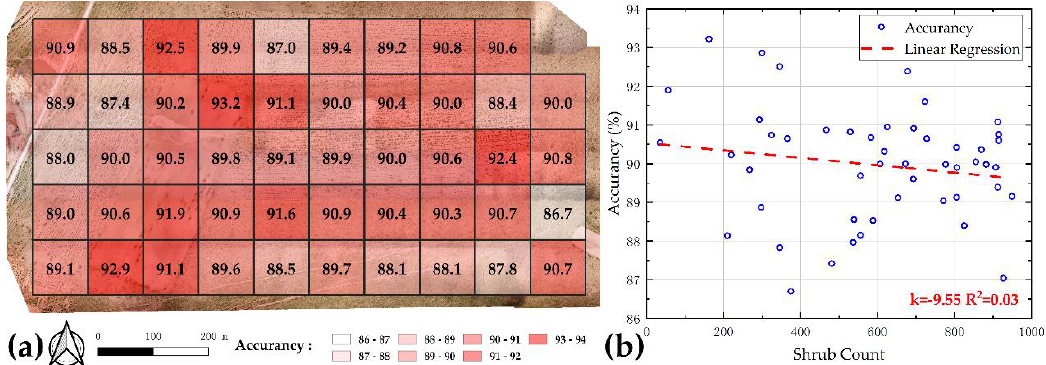
Figure 6. Accuracy analysis in the GGA: ( a ) accuracy of each region; ( b ) the relationship between accuracy and shrub count.